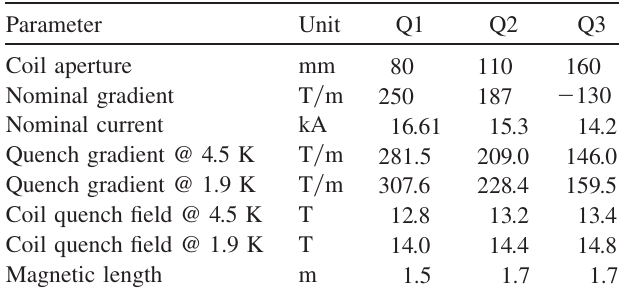
TABLE II. IR quadrupole